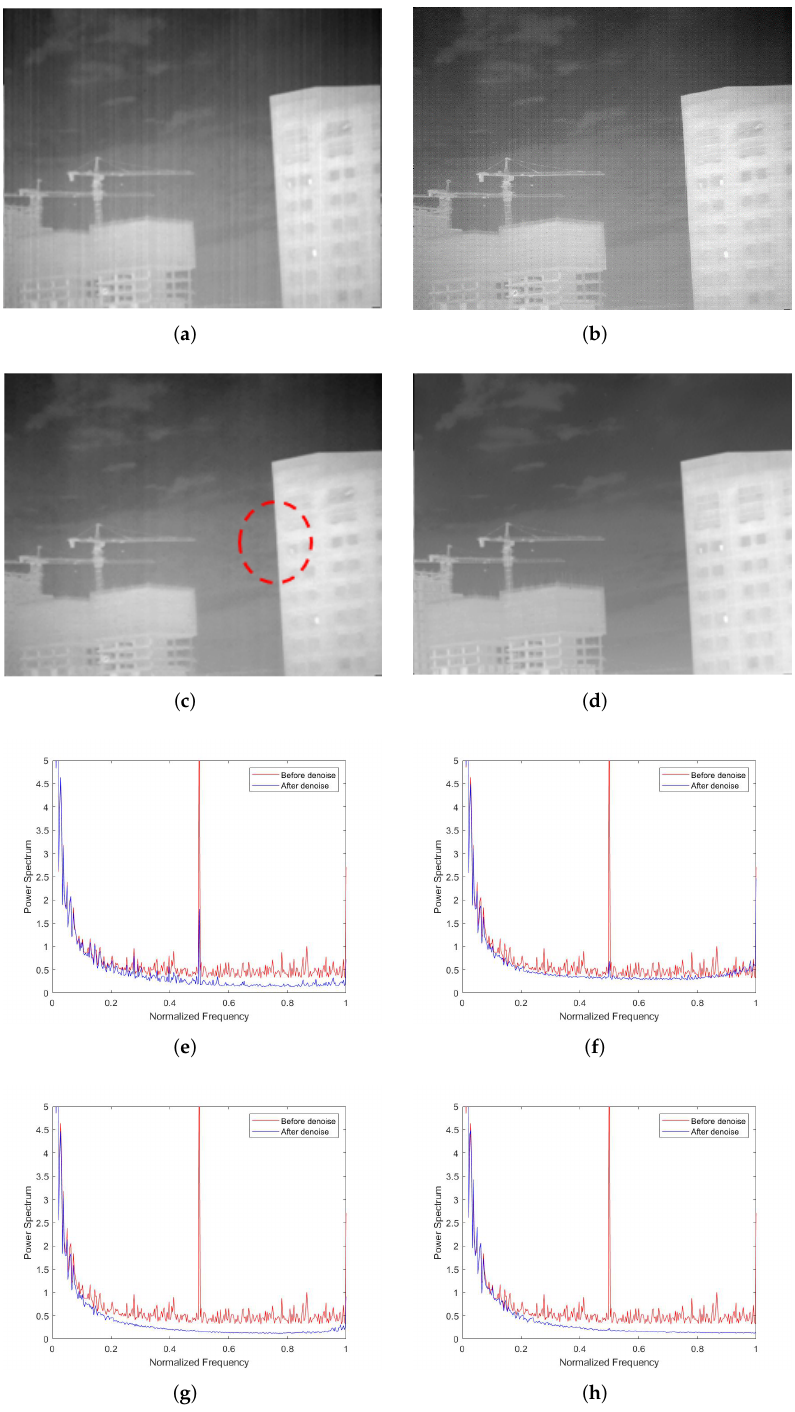
Figure 14. Denoising effects of different methods on an image of complex buildings : (a) MSGF; (b) WAGE; (c) TVGF; (d) our approach; (e) MSGF; (f) WAGE; (g) TVGF; (h) our approach.